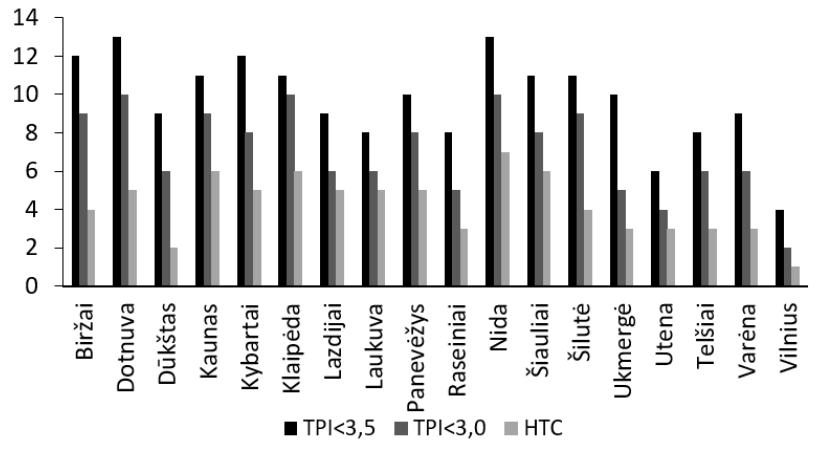
Fig. 7. Number of droughts recorded at weather stations according to HTC, TPI < 3.5, and TPI < 3.0 in